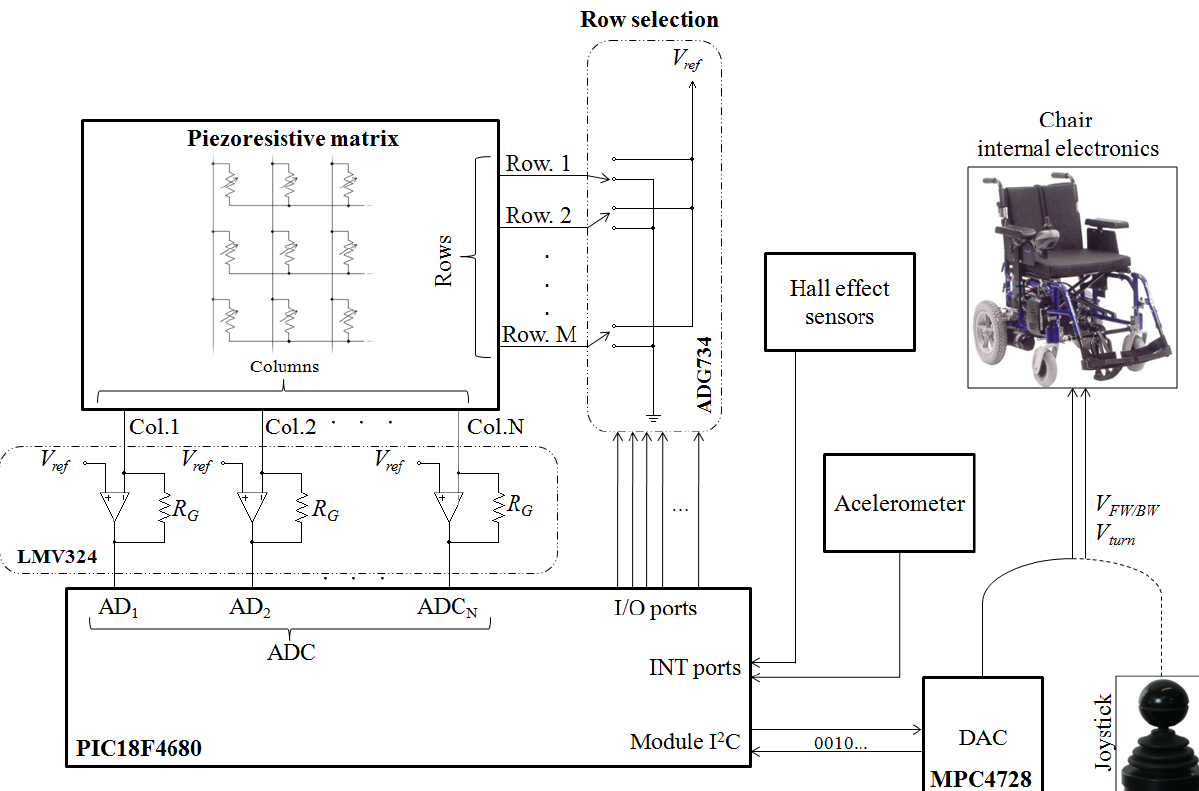
Figure 5. Control electronics scheme.